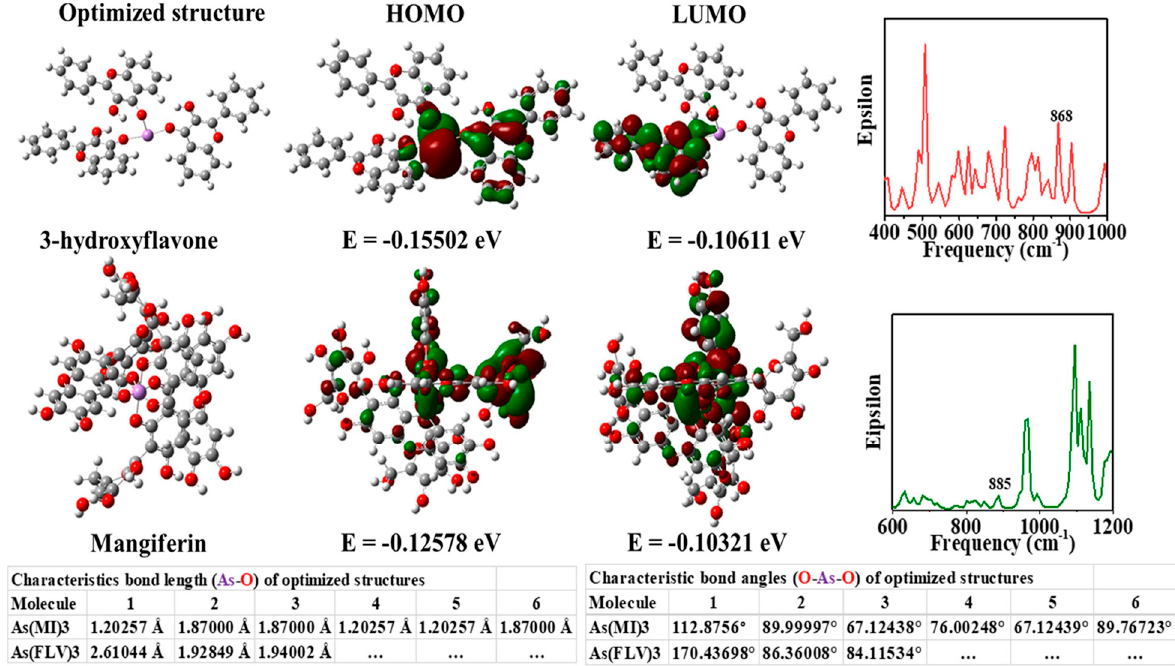
Figure 3. Images of theoretically optimized arsenic complexes with FLV (3-hydroxy flavone) and mangiferin (MI), highest occupied molecular orbital (HOMO), lowest unoccupied molecular orbital (LUMO), and a theoretical infrared (IR) spectrum [64]. Copyright 2020, reproduced with permission from Elsevier B.V., Amsterdam, The Netherlands.